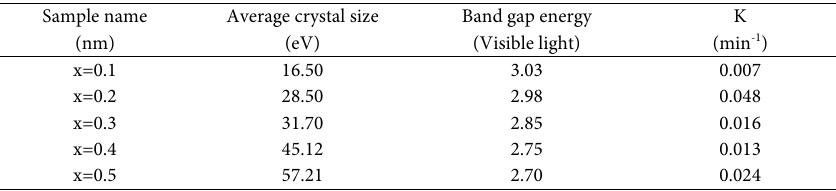
Table 2. The average crystal size, band gap energy (E g ) and reaction rate constants (k) of MO photodegradation for different Cd x Zn 1-x O